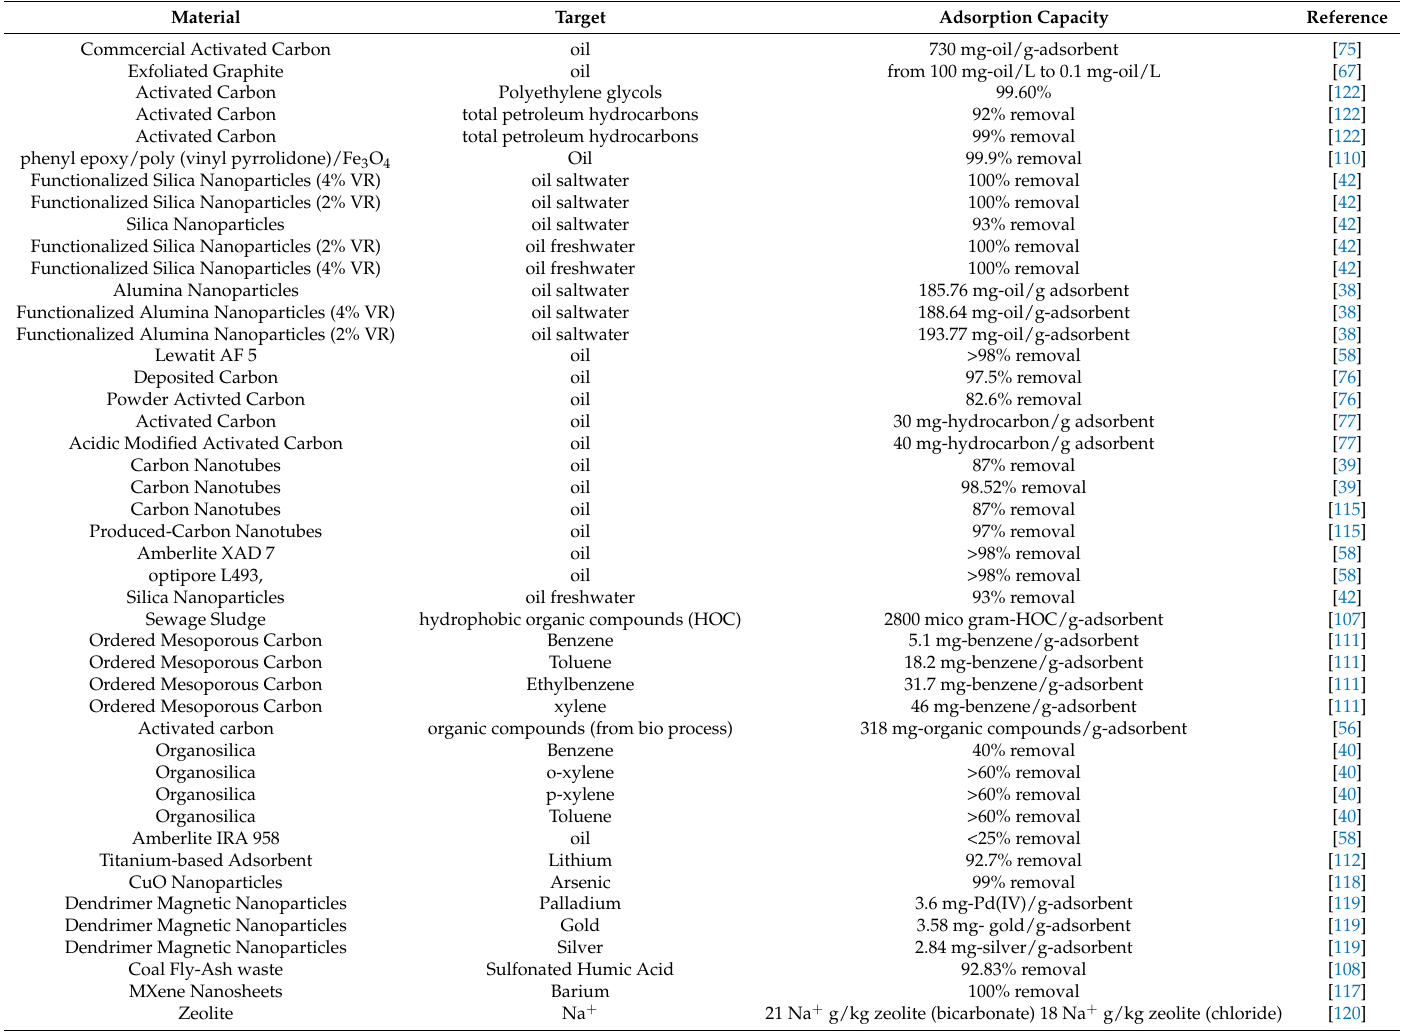
Table 6. Non-Natural adsorbents discussed in this